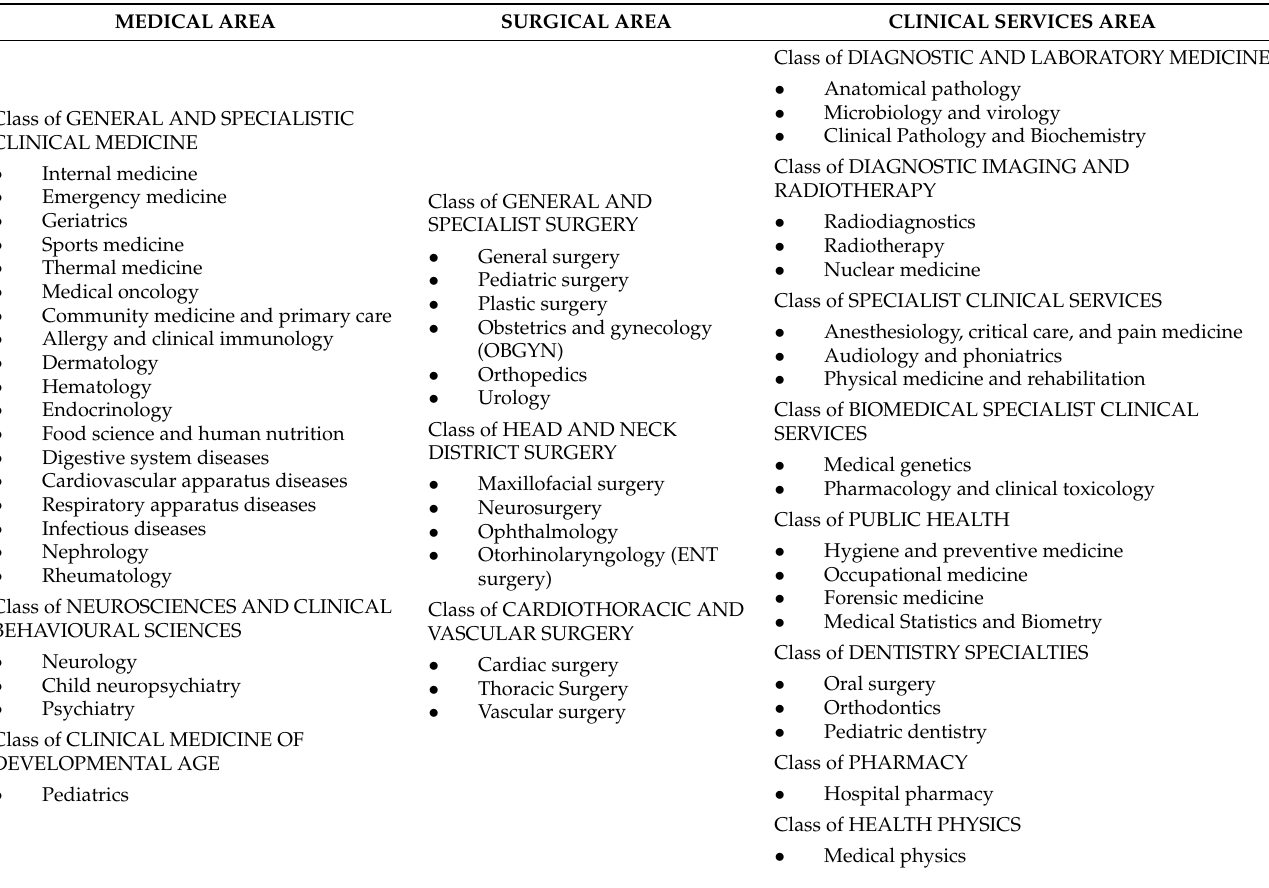
Table A1. Medical specialties divided into areas, classes, and